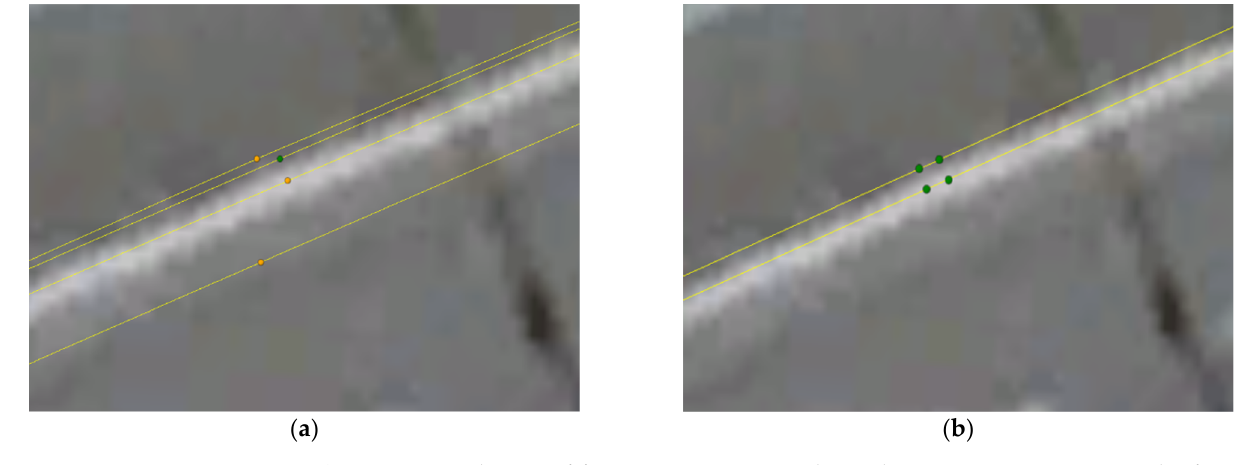
Figure 11. Distribution of four antennas on Google Earth (GPST 03:03:37): ( a ) Result of RTK; ( b ) Result of BCAFM.